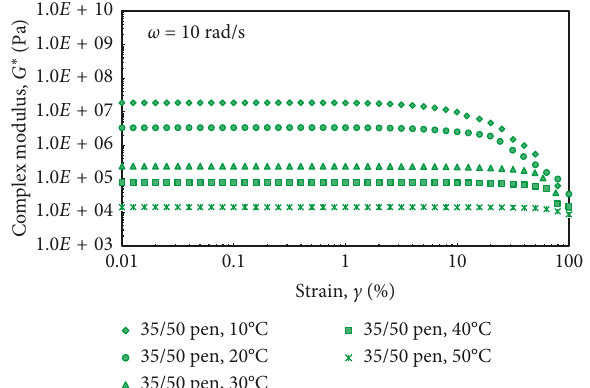
vs. c )— Figure 11: Temperature sweep test results at 10rad/s: G ∗ (35/50 pen and CSR).